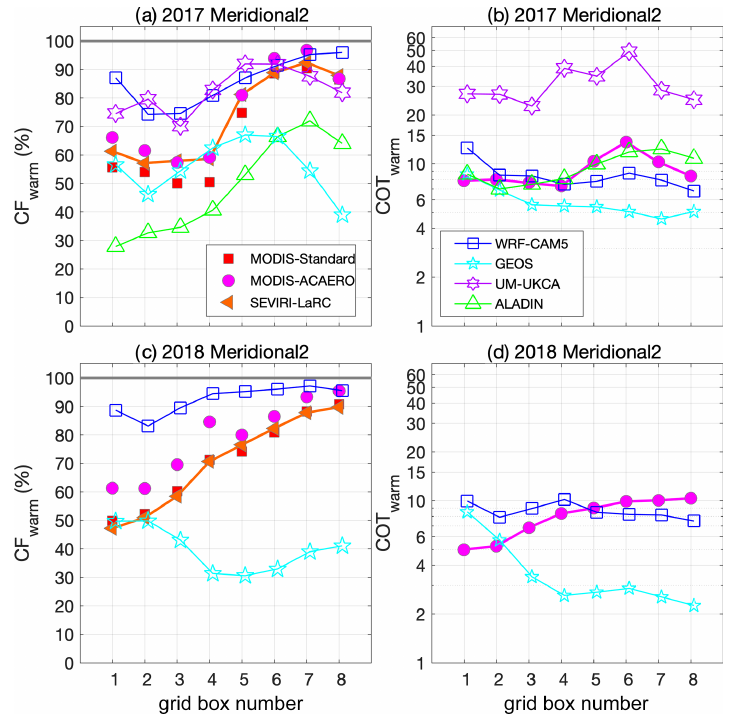
Figure 24. As in Fig. 23 but for the 2017 (a, b) and 2018 (c, d) meridional 2